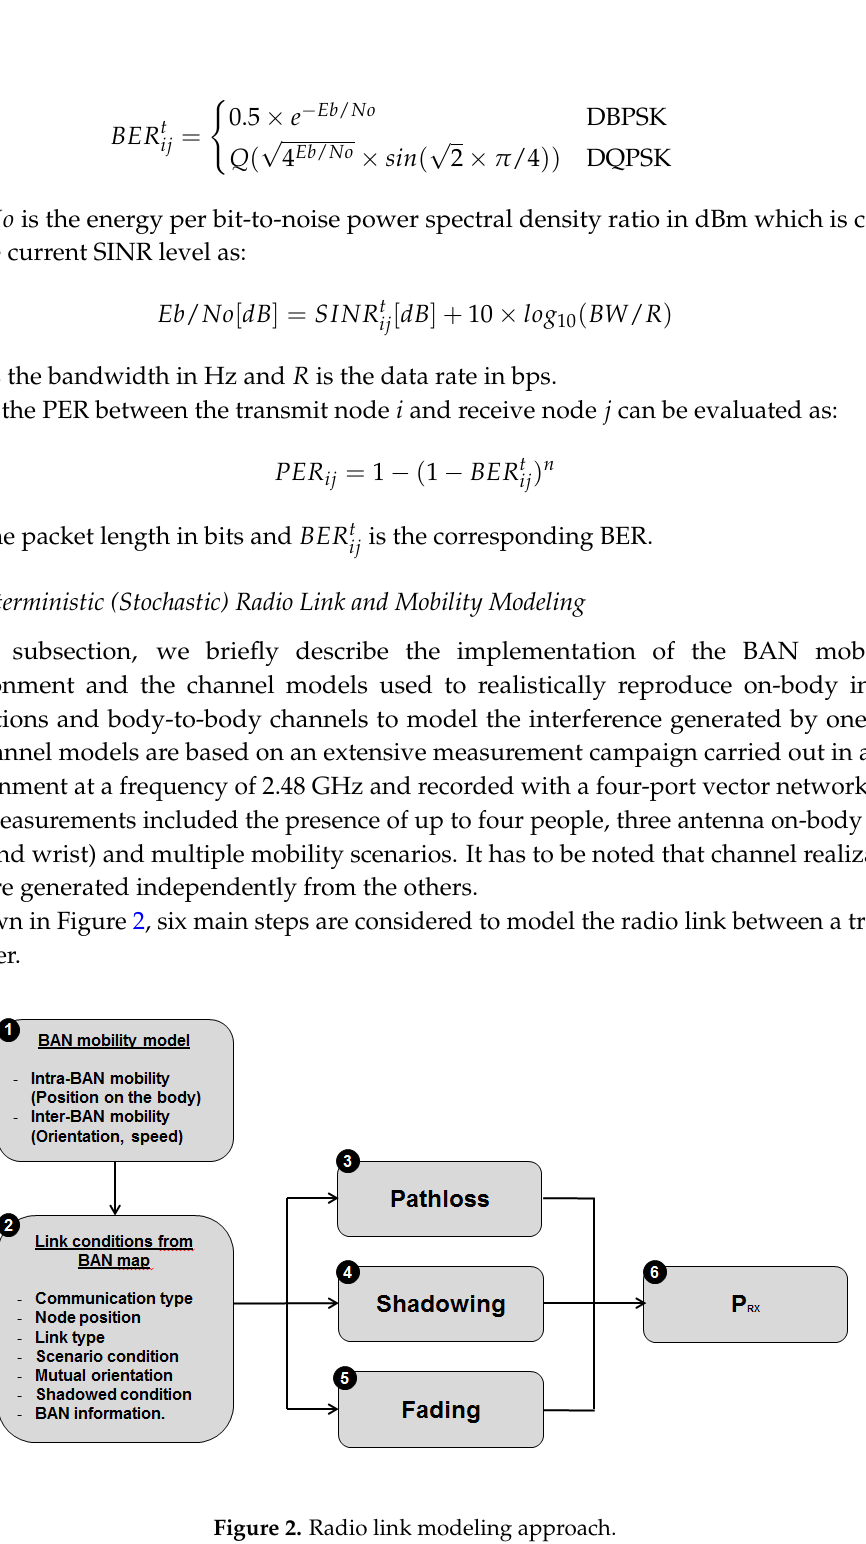
Figure 2. Radio link modeling